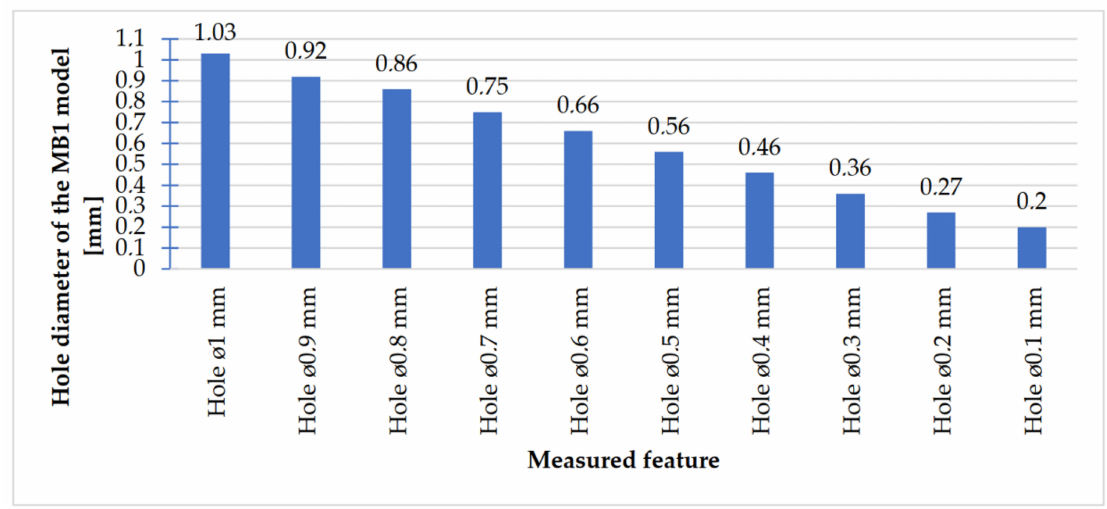
Figure 19. Average values calculated based on the cylindrical holes measurement results with dimensions Ø1–Ø0.1